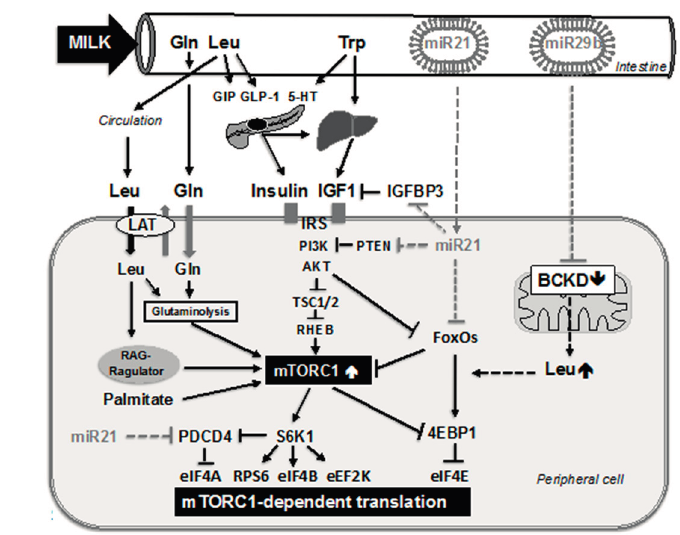
Figure 2. Working model of milk-induced mTORC1-dependent translation. Milk’s hardware is represented by fast-hydrolyzed amino acids leucine (Leu), glutamine (Gln) and tryptophan (Trp). Gln promotes cellular Leu uptake via the bidirectional amino acid transporter